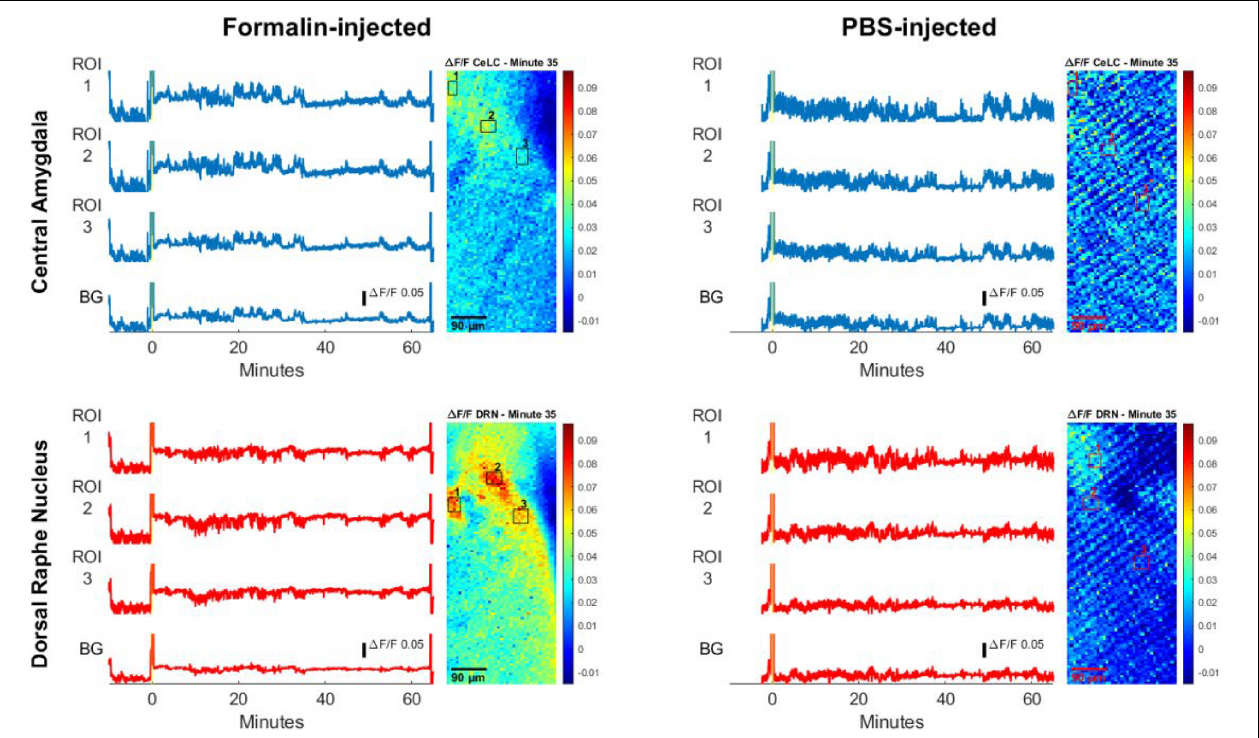
FIGURE 7 | Calcium traces of specific regions of interest (ROIs). Calcium measurement of Formalin-injected mouse and PBS-injected mouse. The yellow bar on the line graph marks the injection period. The blue line graphs show measurements in the CeLC, while the red line graphs show measurements of the DRN. The background values (BG) are the average of all the pixels outside the ROIs. Beside the line graphs are images of sample frames where ROIs are enclosed in black or red